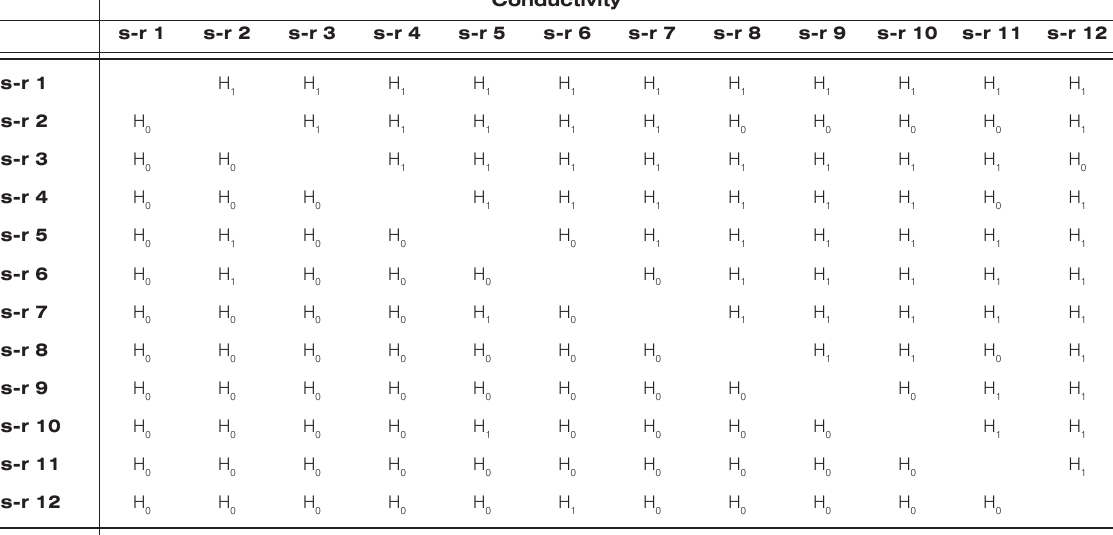
– no differences between two regions, H 0